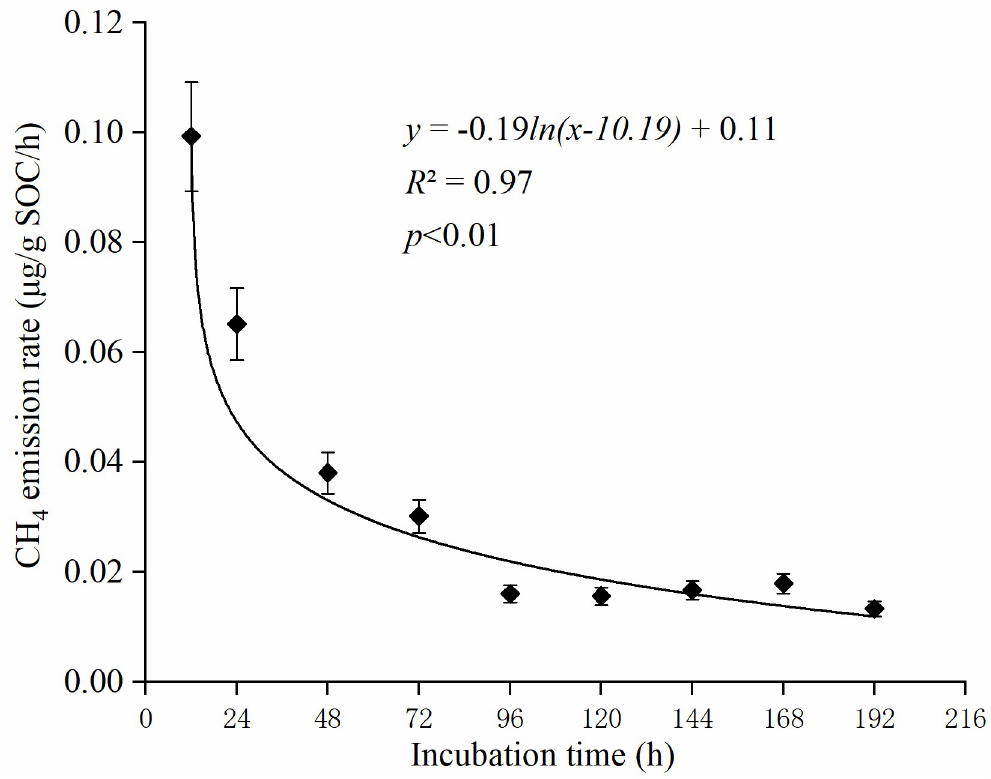
Fig 2. Fitting relationship between NM-CH 4 emission rates and incubation time in aerobic environment at 70 ˚C with natural soil water contents in first 192